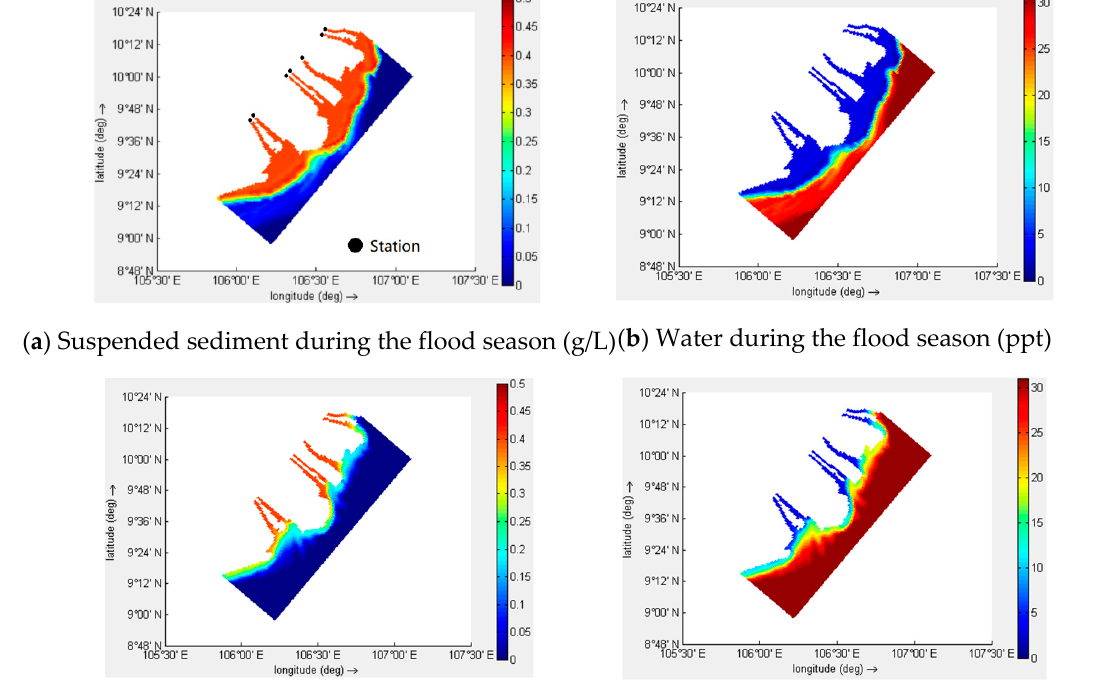
Figure 1. The transport of suspended sediment ( a , c ) and water ( b , d ) in the Mekong River Delta during the flood ( a , b ) and dry scheme 2018. Table 1. Average values of water, sediment fluxes and wind velocity in the Mekong River during the flood and dry season in